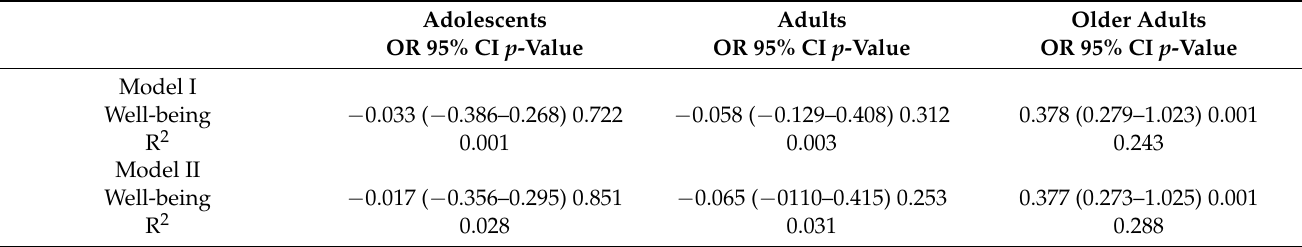
Table 4. Results of linear regression analyses for PA-total and well-being motivational